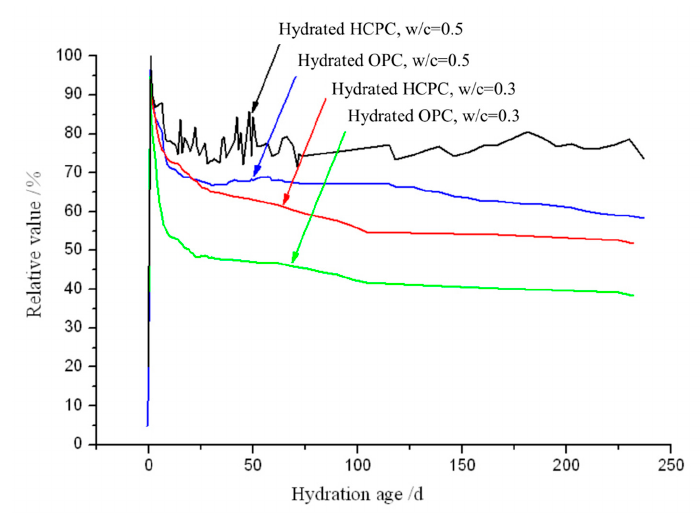
Figure 5. Profiles of the percentages of the integral intensities of the AFt’s characteristic peaks, at different hydration ages, relative to the reached maximum intensities of the AFt peak of the samples.